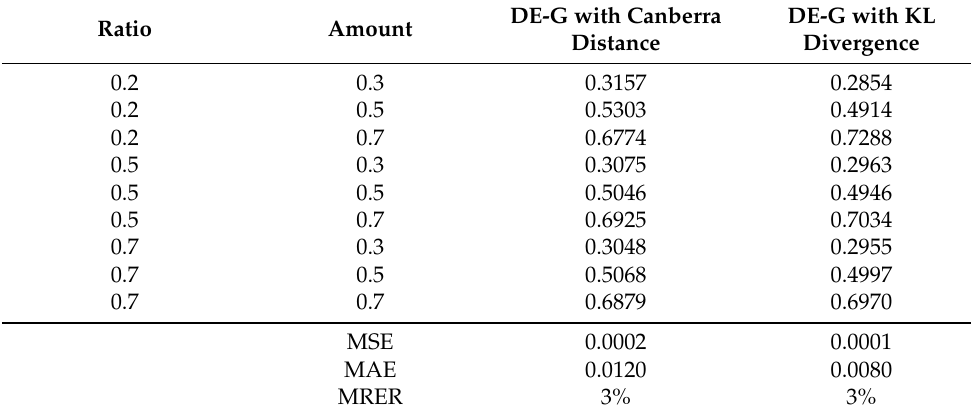
Table 4. Salt-and-pepper noise parameter estimation.